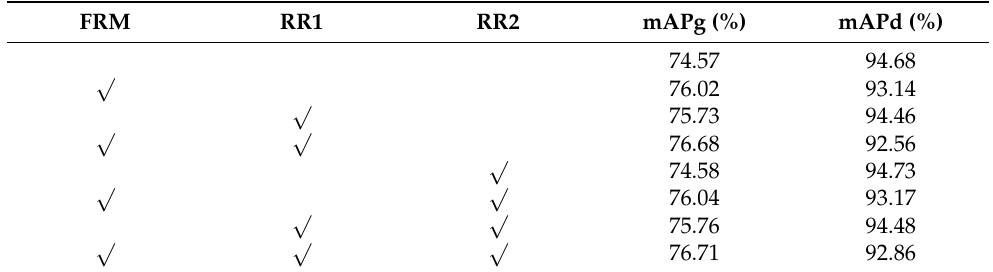
Table 2. Effect of Feature Refine Model. Each colour represents a different comparison experiment.